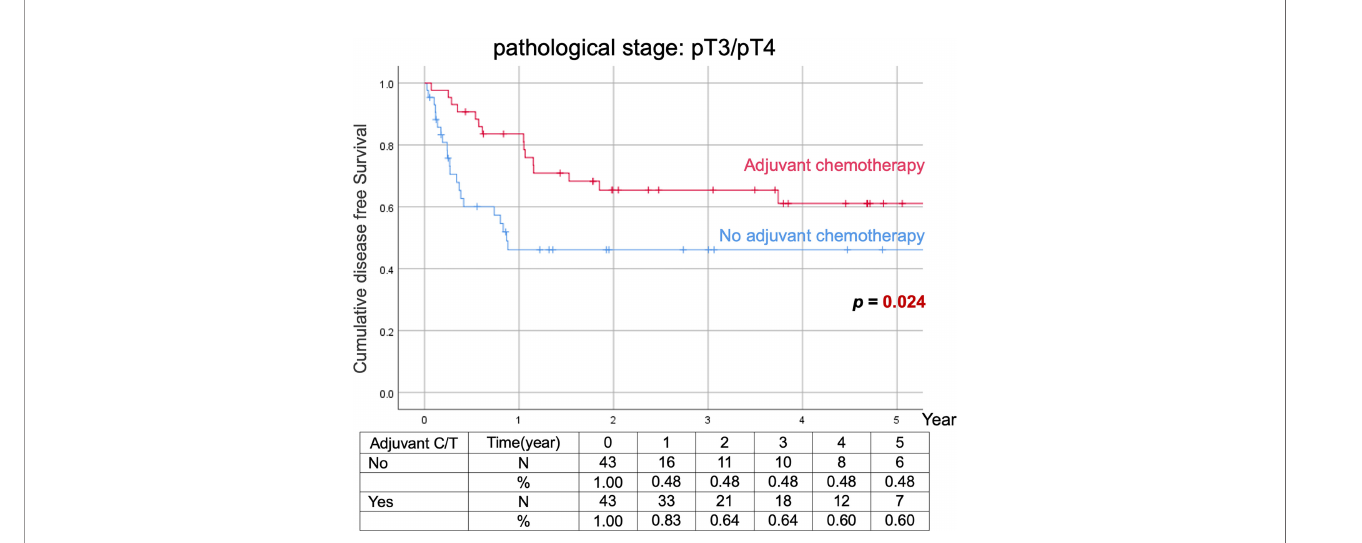
FIGURE 4 | Kaplan – Meier analyses of disease-free survival in patients with advanced vUTUC with or without adjuvant